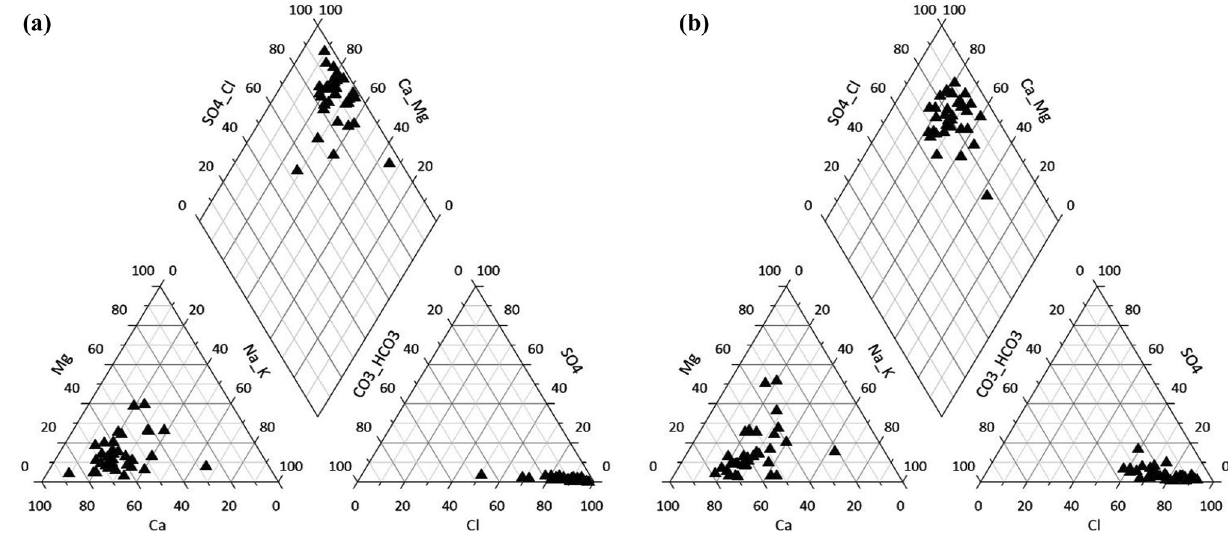
Fig. 4 Piper diagram showing the major groundwater types of the study area during a PM and b PoM